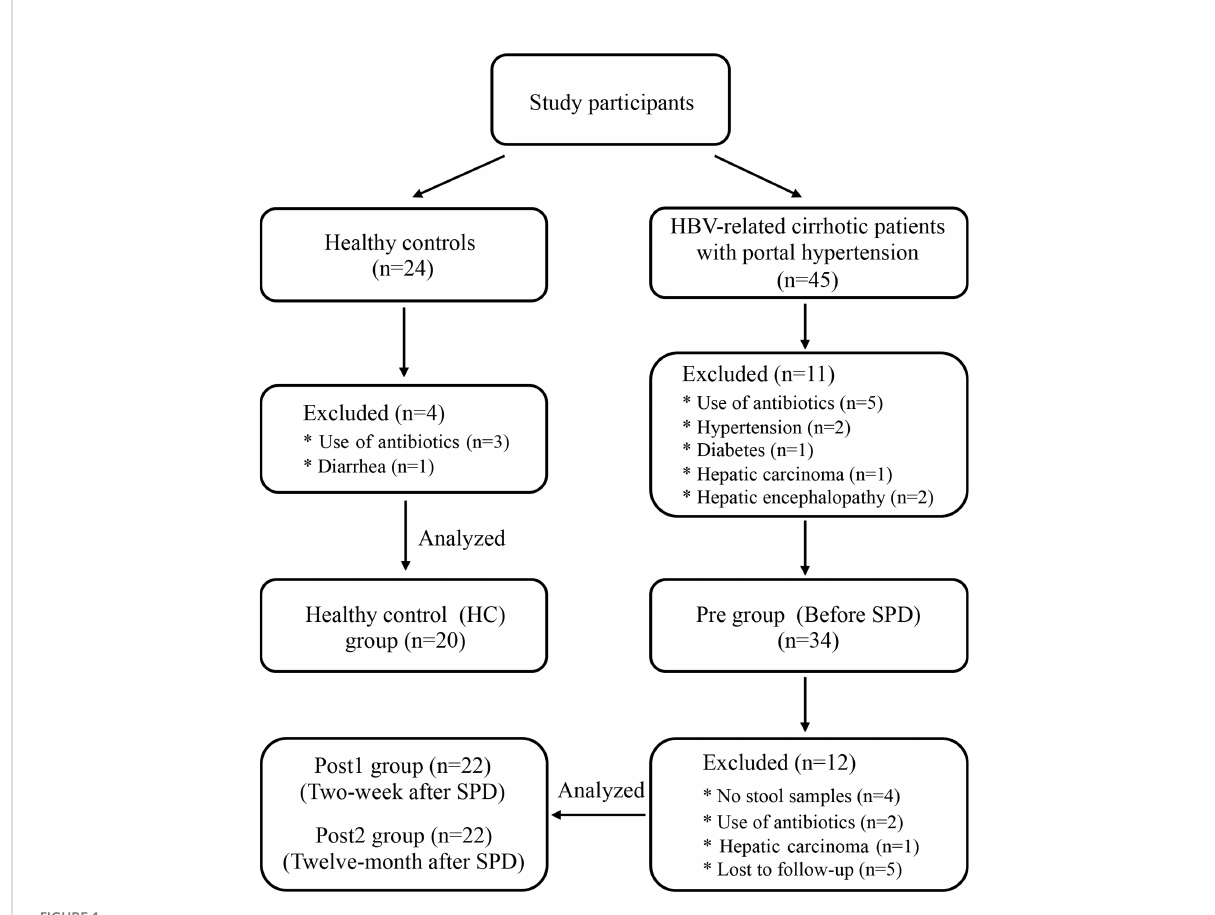
FIGURE 1 Flow chart of participants through each stage of the clinical study.